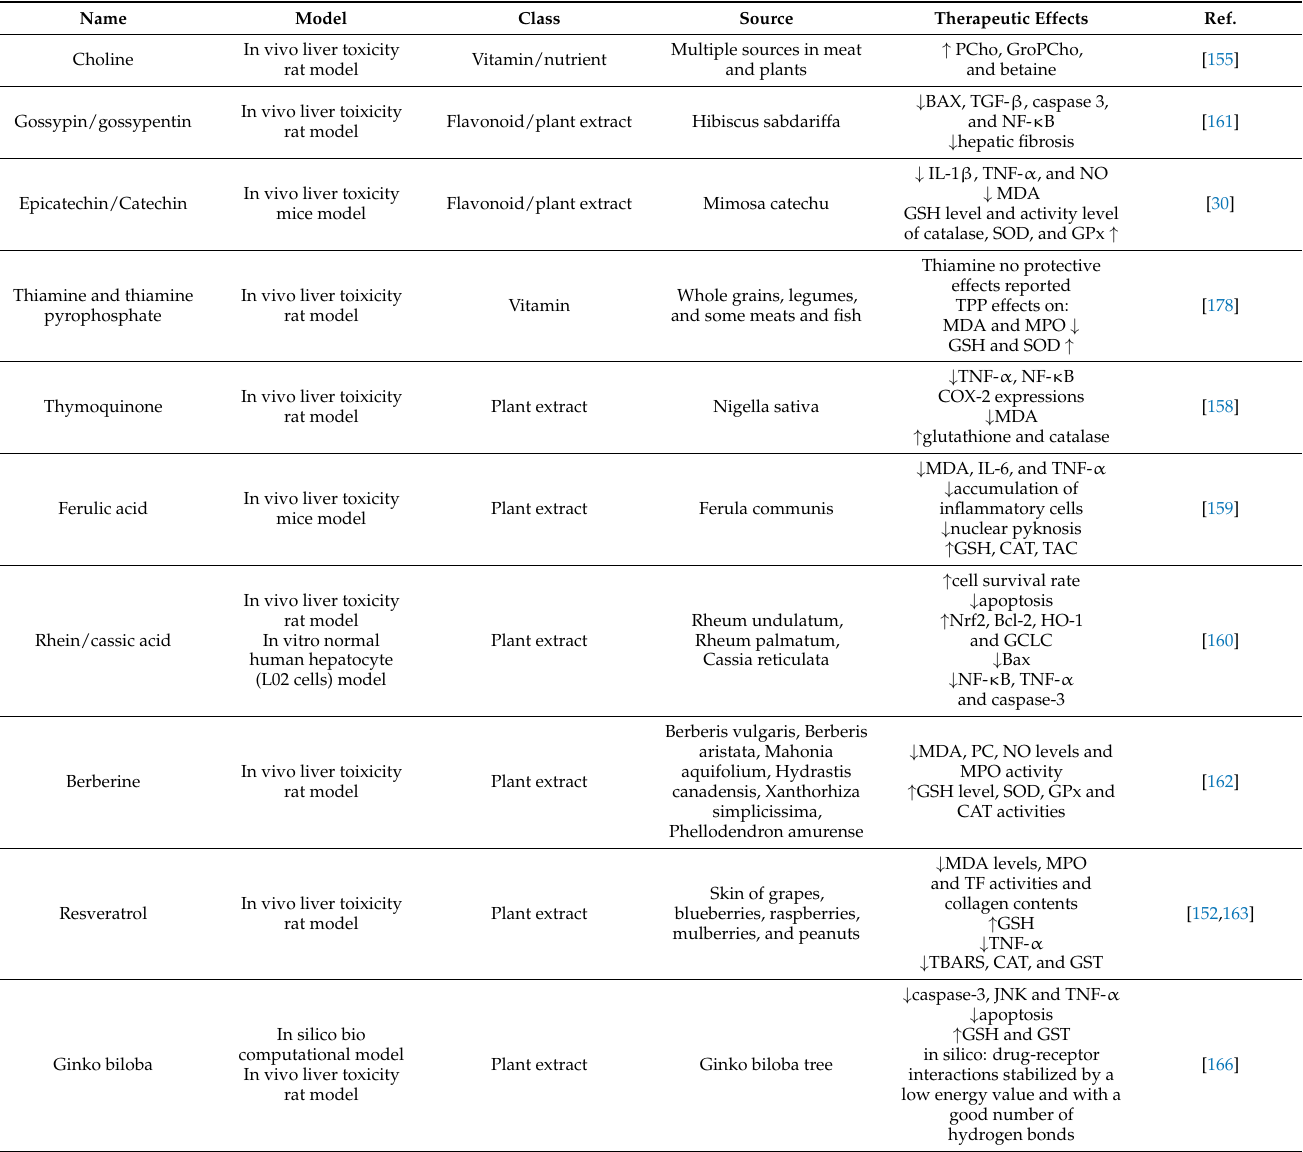
Table 3. End-organ effects of nutraceuticals used in experimental models of MTX-induced